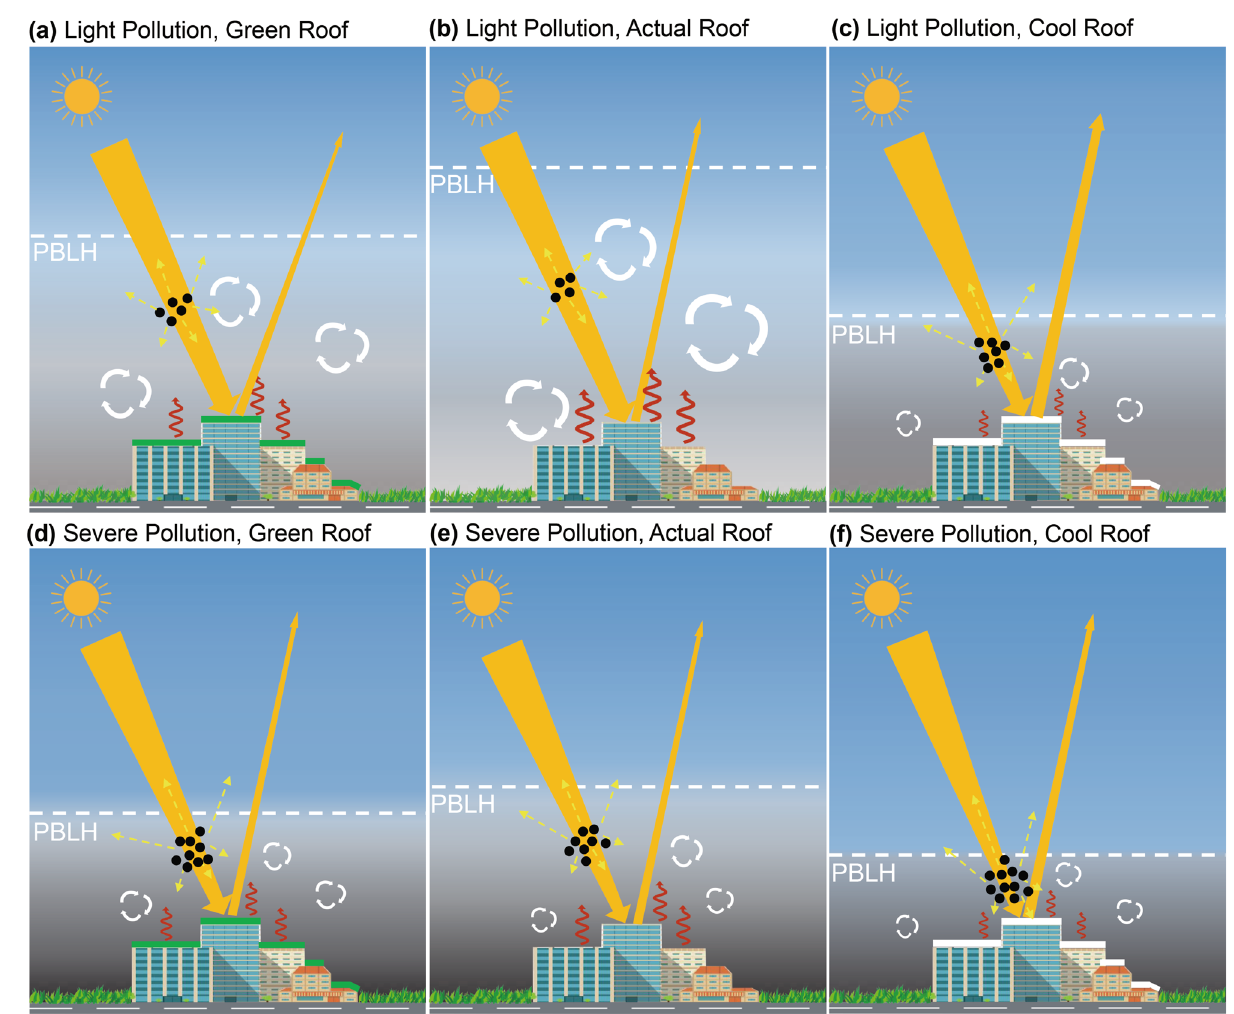
Fig. 5 A conceptual fi gure of pollution severity-regulated effects of roof strategies on winter PM 2.5 . The conceptual scheme displays interactions between surface energy balance, structure of PBL, ARF, and aerosol concentrations after the applications of cool roofs and green roofs at different pollution levels at daytime. a Green roof under light pollution. b Actual roof under light pollution. c Cool roof under light pollution. d Green roof under severe pollution. e Actual roof under severe pollution. f Cool roof under severe pollution. Orange arrows represent downward solar radiation and that re fl ected by the surface. Yellow dashed arrows are the re fl ected and scattered solar radiation by aerosols. Red wavy arrows show the upward forcing of the surface. White dashed lines are the PBLH. White circled arrows represent the turbulent mixing in the PBL. The various shades of background colors mean the different pollution